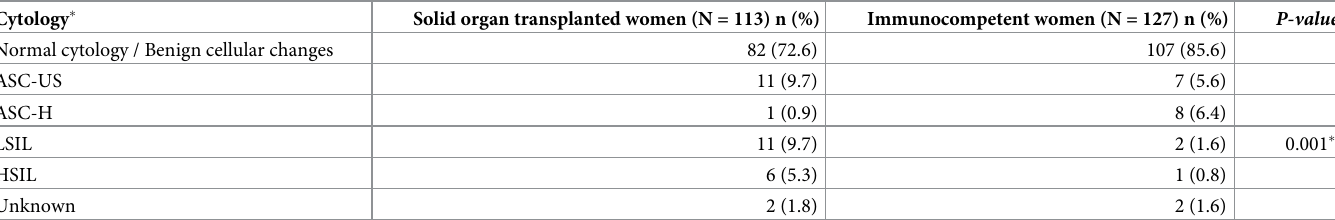
Table 4. Results of liquid-based cytology, by study population.